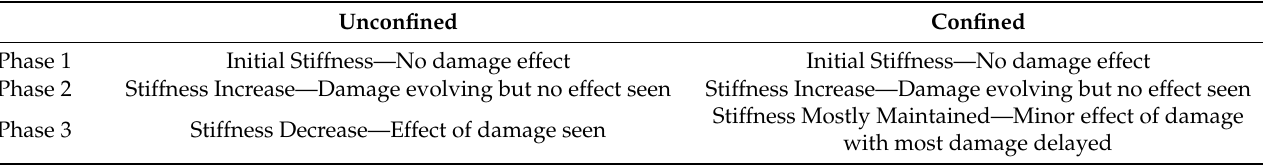
Table 4. Summary of Phase Stiffness